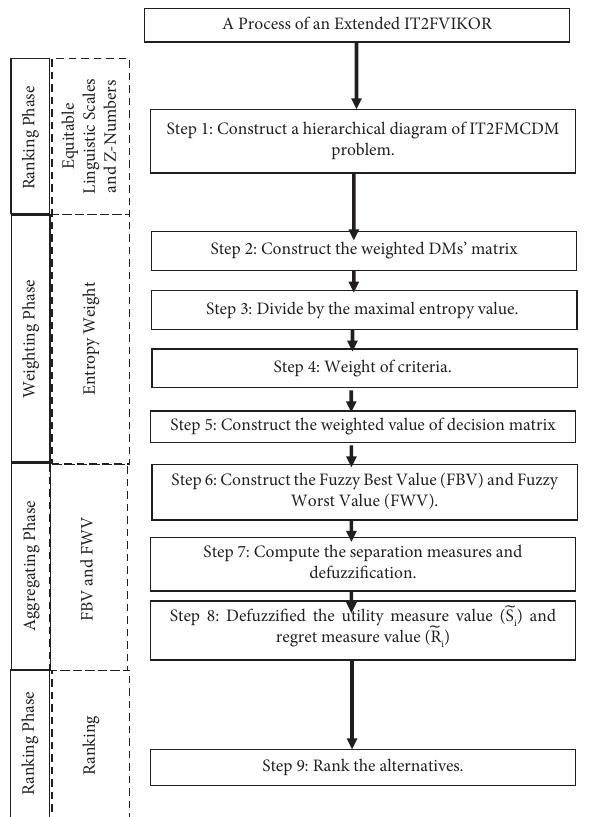
Figure 4: Te positive and negative reliability for the extended